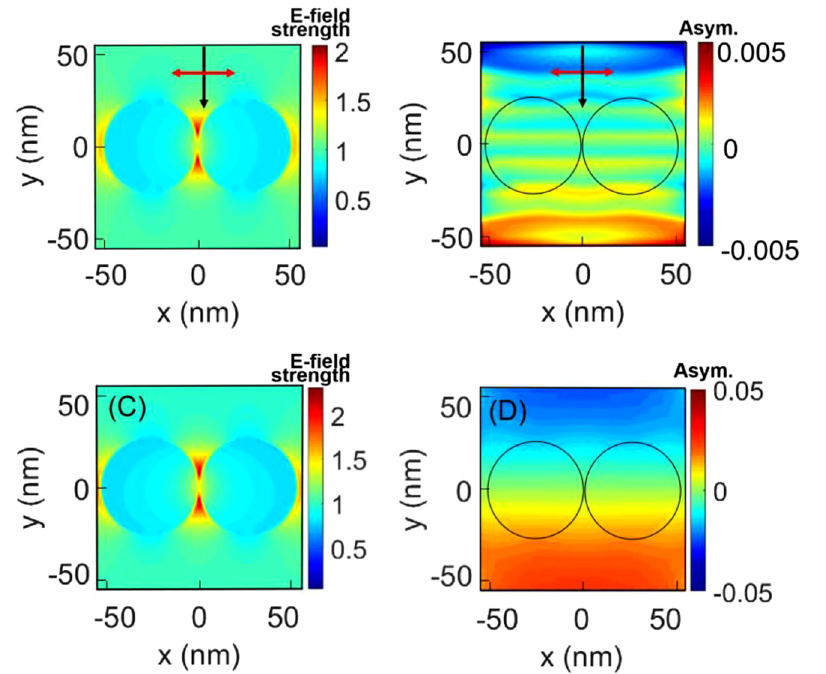
Figure 3: Finite Difference Time Domain (FDTD) calculations (using Lumerical) of the induced near fields of silica nanoparticle systems. (A) The distribution of the maximum near field strength around a nanoparticle dimer consistingof two50nmSiO 2 nanoparticles, excited by femtosecond laser pulses at 800 nm. The color scale represents the enhancement factor of the fi eld amplitude. The black and red arrows indicate the laser propagation and polarization directions, respectively. (B) The calculated asymmetry of the fi eld strength from (A) along the laser propagation direction for a dimer system. The black circles indicate the dimer. (C) and (D) are similar to those of (A) and (B) but for the excitation at 400